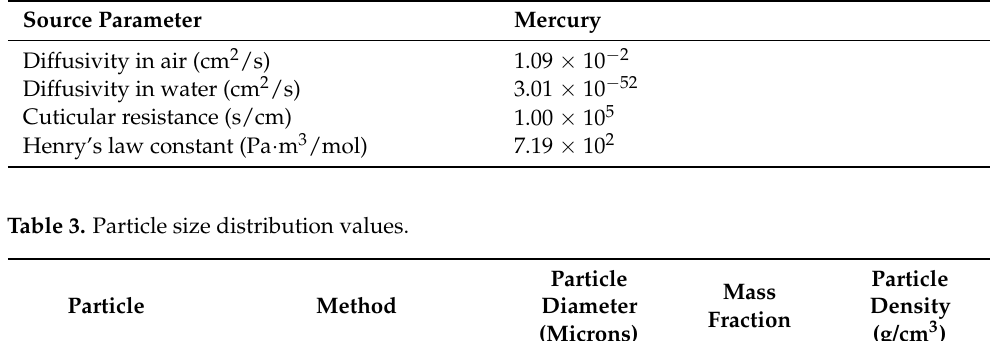
Table 2. Source parameters for gas and particle deposition for mercury.